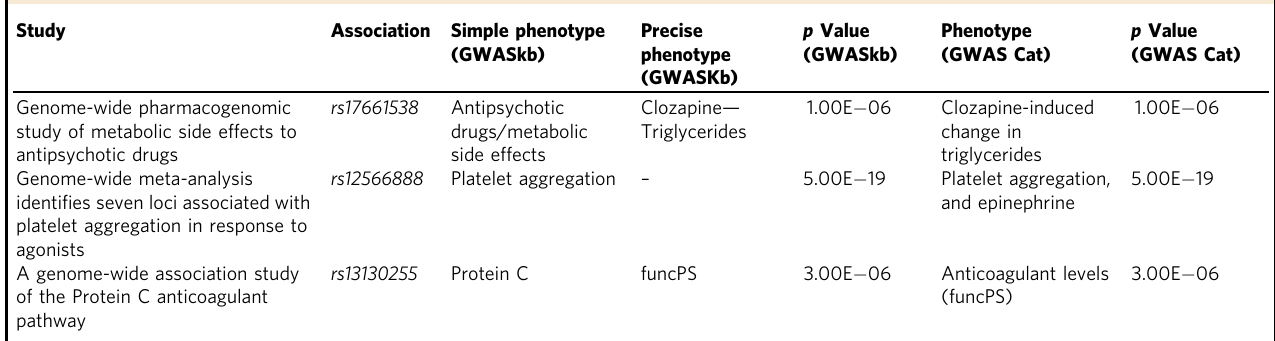
Table 2 Examples of associations identi fi ed by